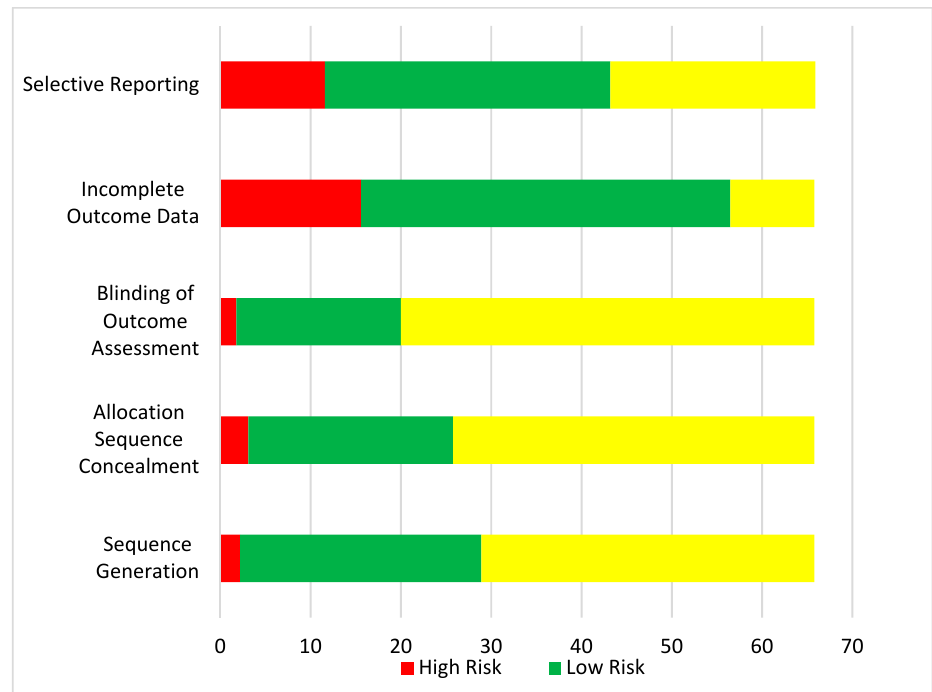
Figure 2. Risk of Bias in Included Trials, N = 148. Note: Blinding was considered low-risk when outcome assessors were masked (i.e., single-blinded). Patient blinding would not be possible given the nature of the interventions.